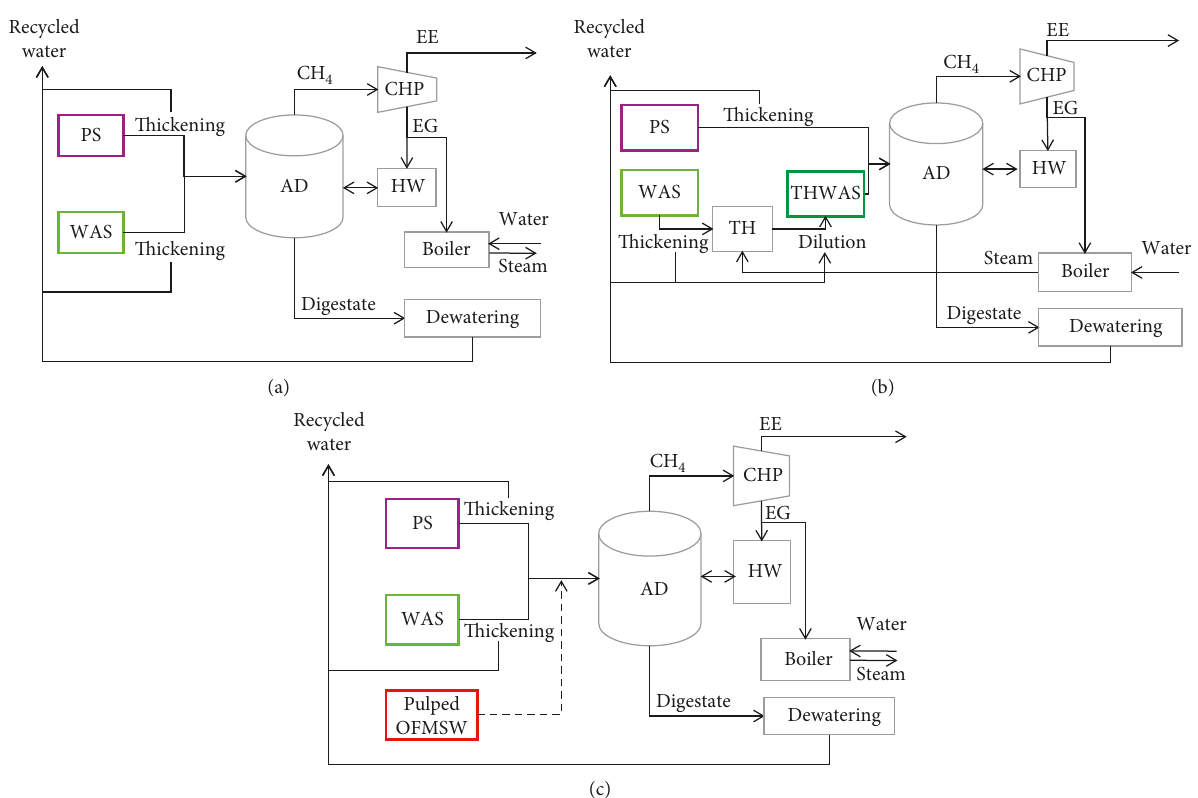
Figure 2: The solid line and energy integration of the biogas produced in (a) scenario 1, (b) scenario 2, and (c) scenario